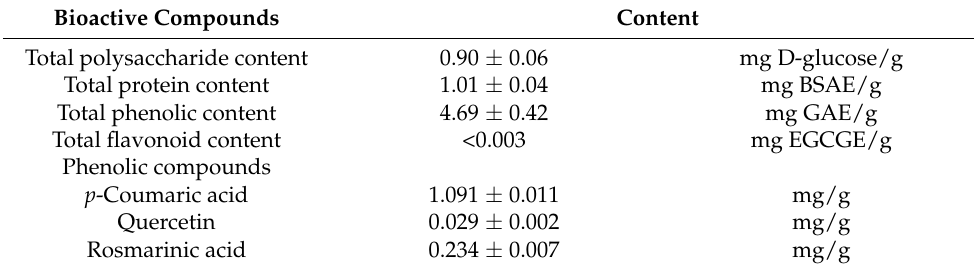
Table 1. Content of bioactive compounds of shallot extract. Bioactive Compounds